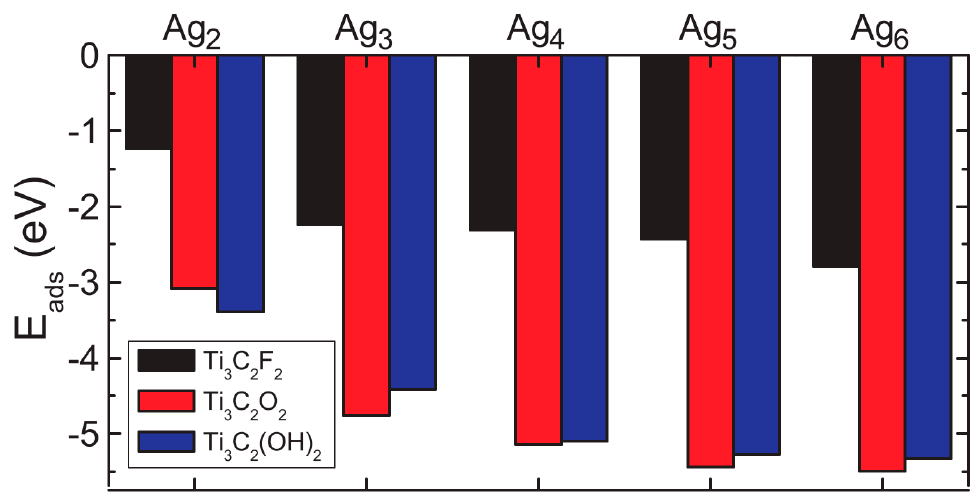
Figure 6. Adsorption energies of Ag n nanoclusters on the surface of Ti 3 C 2 F 2 (black columns), Ti 3 C 2 O 2 (red columns), and Ti 3 C 2 (OH) 2 (blue columns).